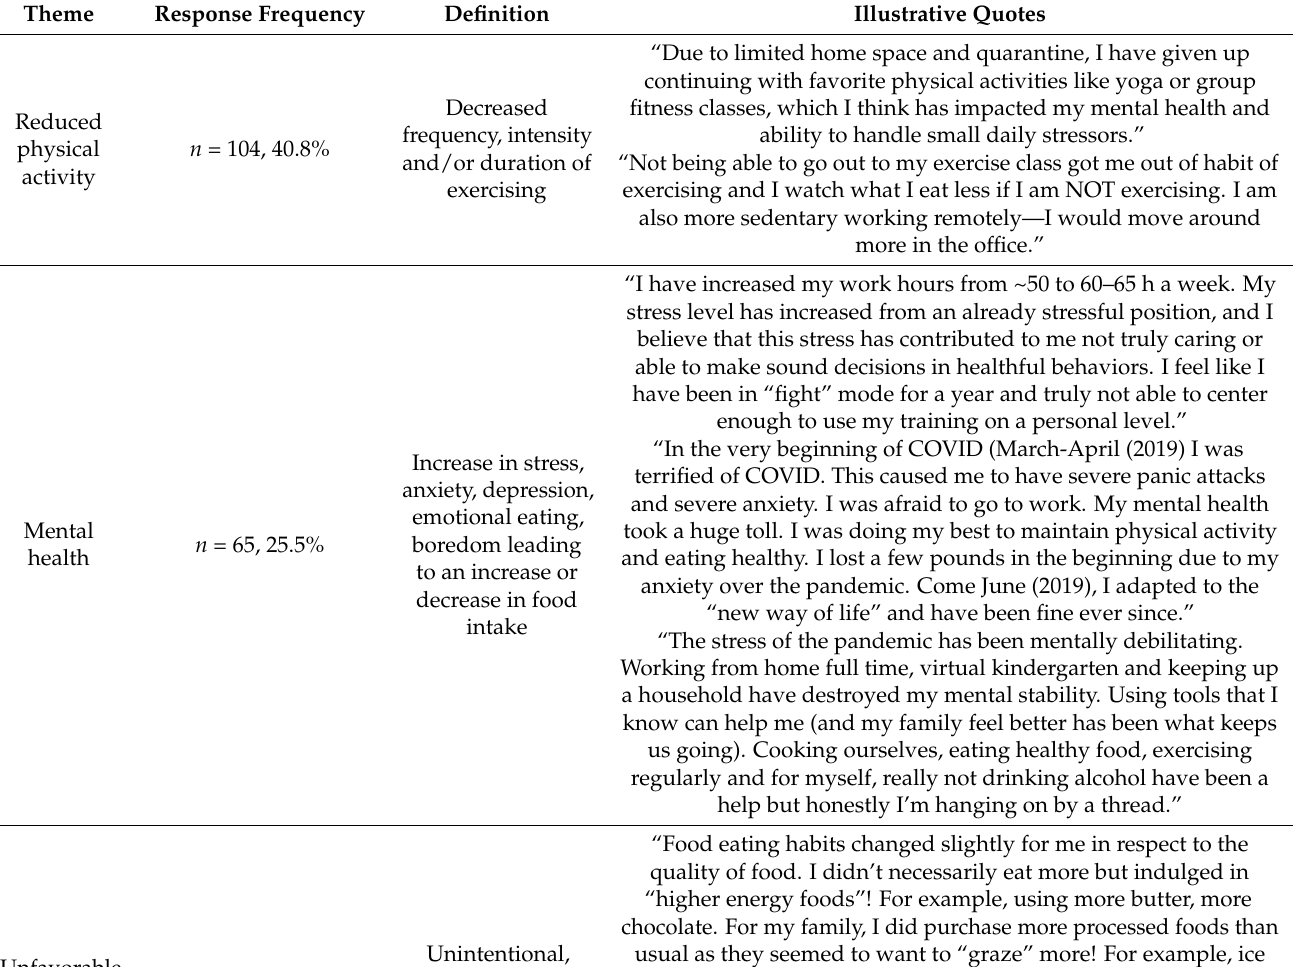
Table 4. Themes, response frequencies, definitions, and illustrative supportive quotes (from Q2) to open-ended question Q1: “If your weight changed during the height of the pandemic period, please describe why you think your weight changed” ( n =